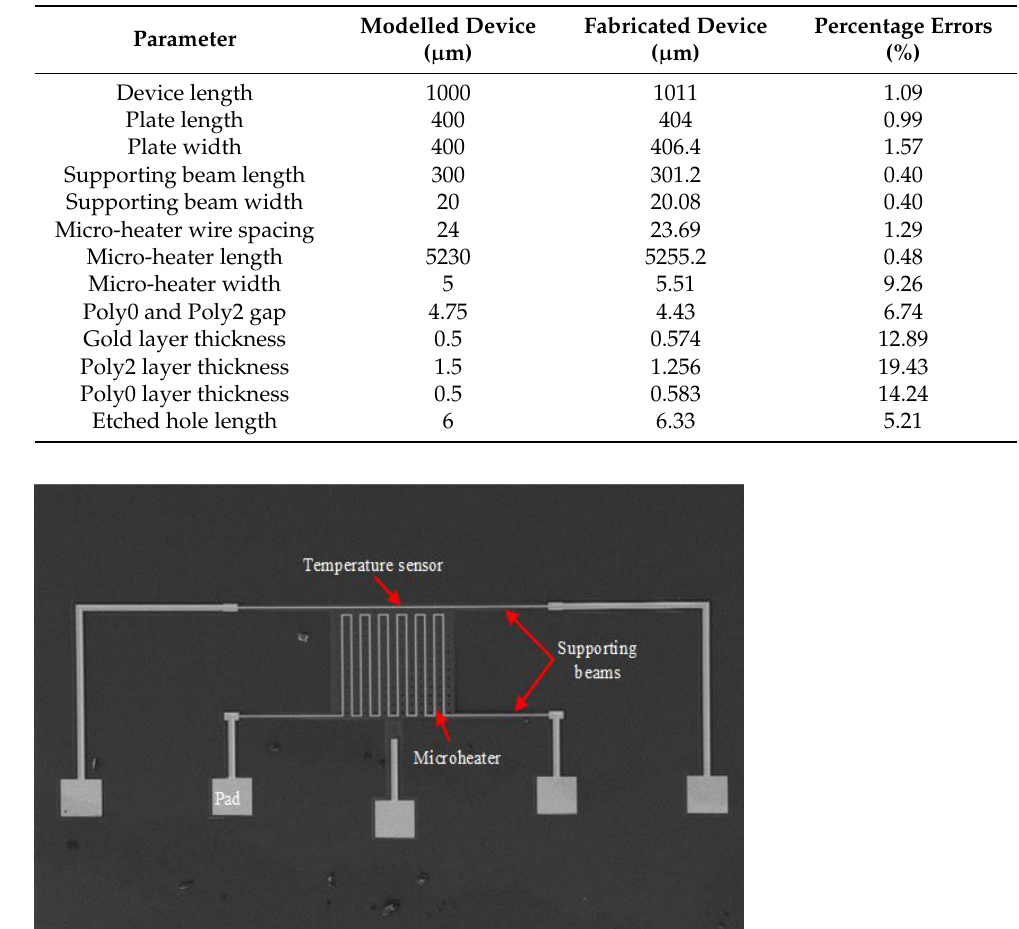
Table 4. Comparison of the theoretically modeled with the fabricated device parameters.